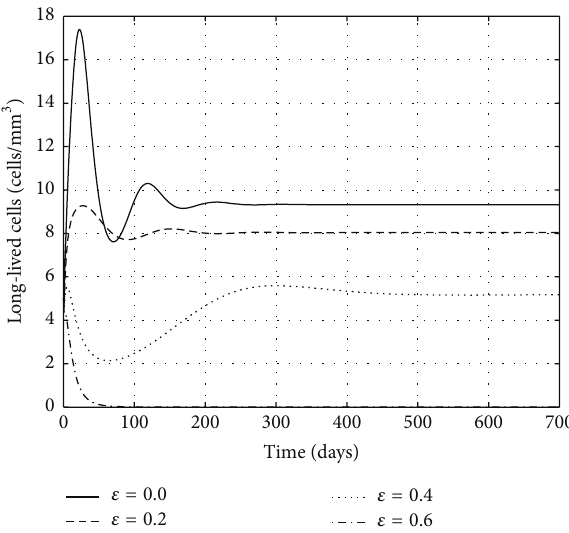
Figure 8: The concentration of long-lived chronically infected cells for model